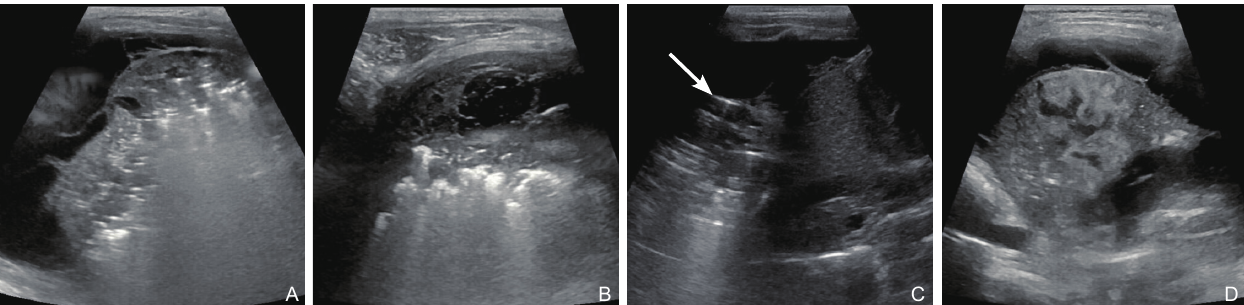
Figure 7 Pneumonia sonograms. (A) Large patchy pulmonary consolidation with massive pleural effusion; (B) The pleura is thickened, and there are effusions in the pleural cavity, with dense point echoes in the effusions; (C) Bronchial pleural fistula, the arrow shows the gas at the fistula; (D) Pulmonary